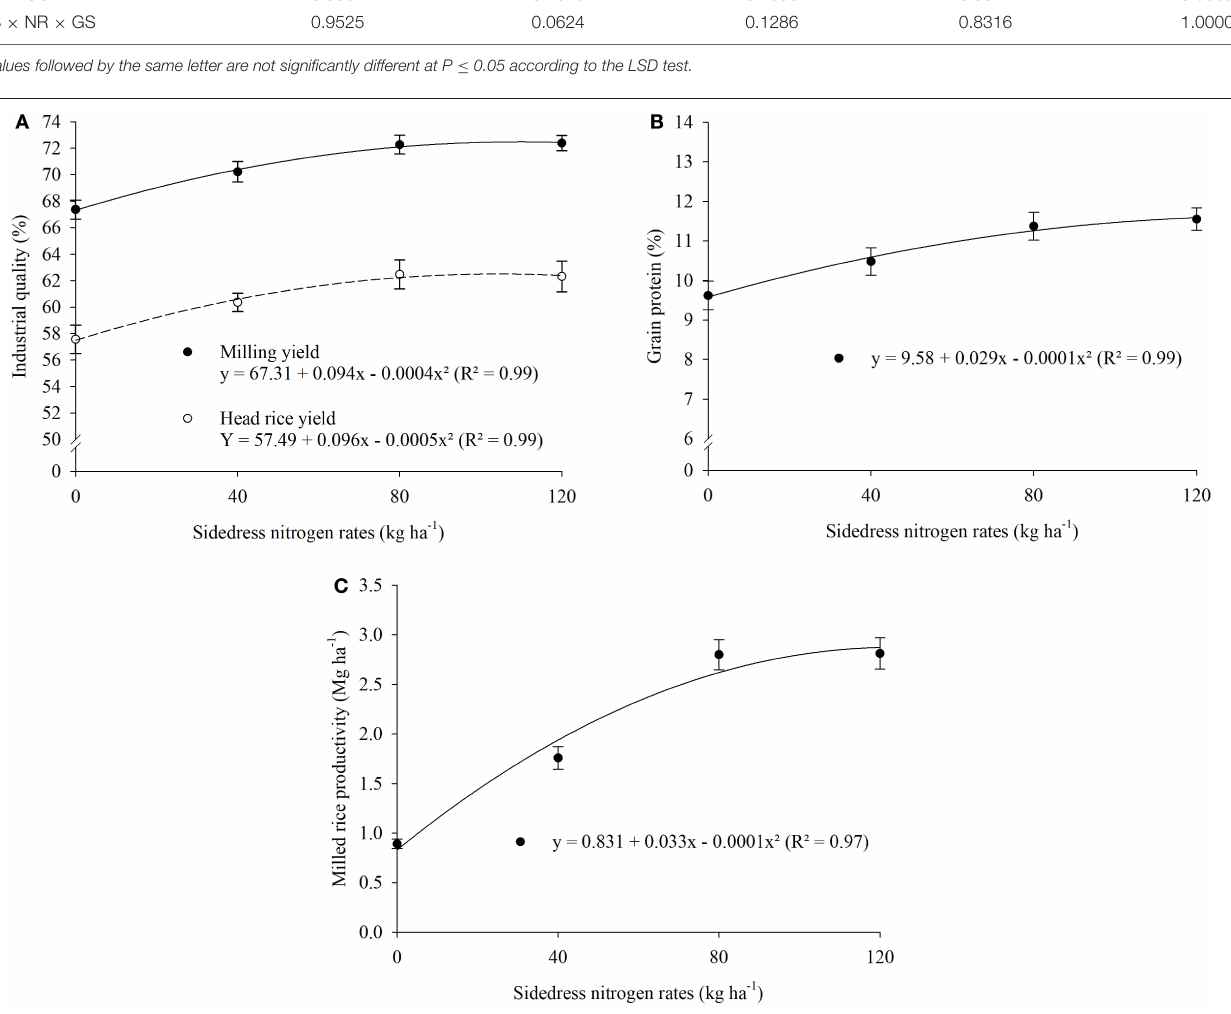
Frontiers in Sustainable Food Systems |